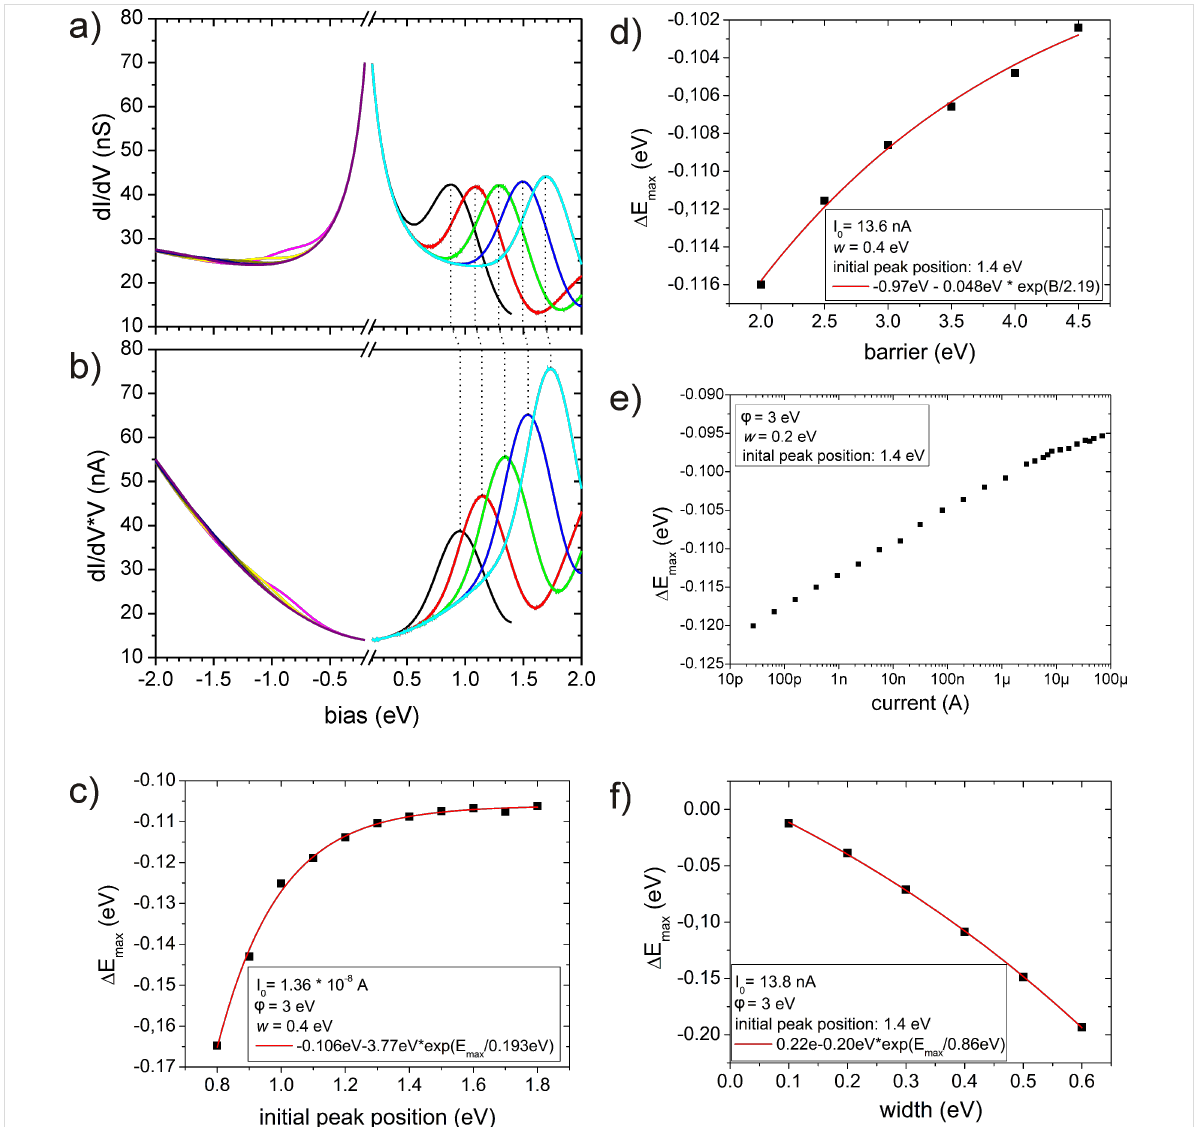
Figure 1: Calculated ∂ V I–V curves (a) and ( ∂ V I × V ) –V curves (b) for different peak positions in the sample DOS ranging from − 1.8 eV to +1.8 eV. The model DOS of tip and sample are constant with an additional Gaussian peak in the sample DOS at the given position. Parameters are: Barrier height φ = 3 eV, I 0 = 13.7 nA. The initial peak positions were ±[1.0 (black, magenta), 1.2 (red, yellow), 1.4 (green, dark yellow), 1.6 (blue, navy), 1.8 (cyan, purple)] eV. Panels (c) through (f) show the dependence of the peak positions in ∂ V I on the barrier height, φ , the set current, I 0 , the initial peak